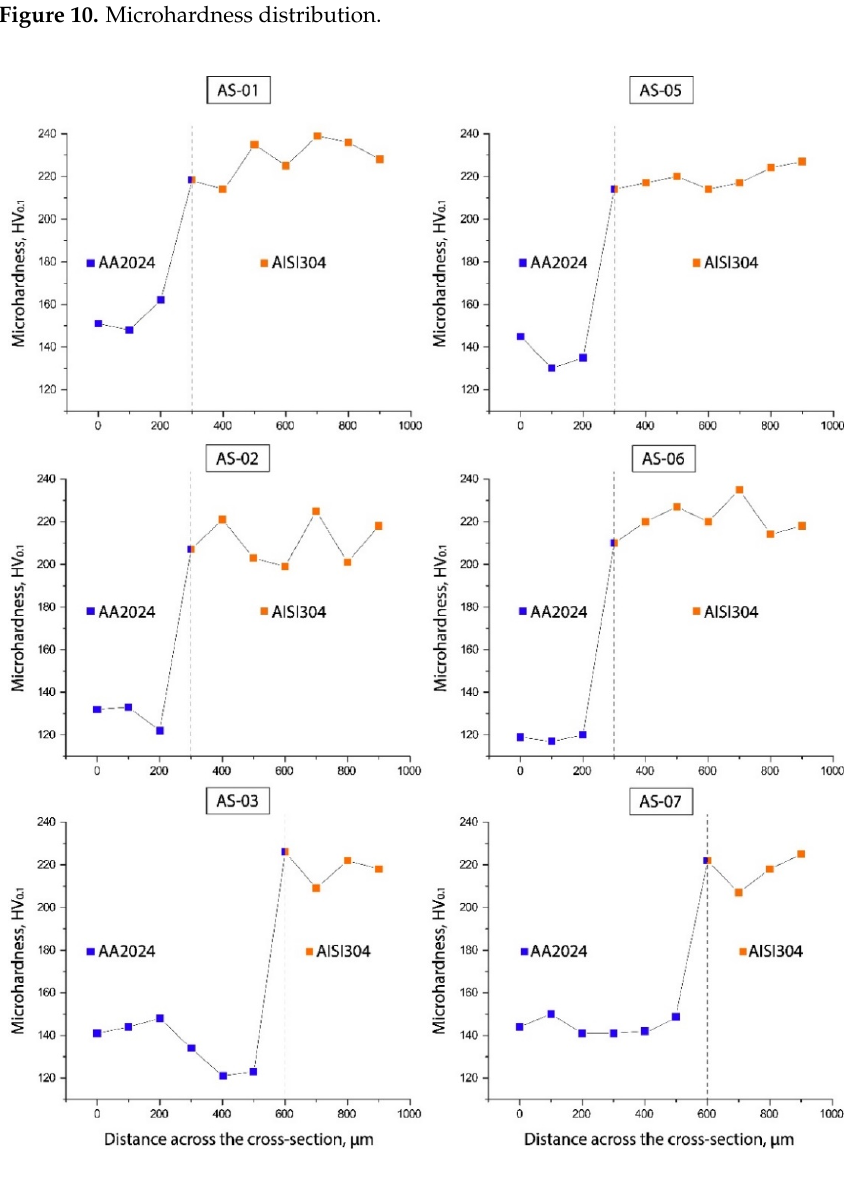
Figure 11. Microhardness profiles in cross-sections of the P-FSSW welds.